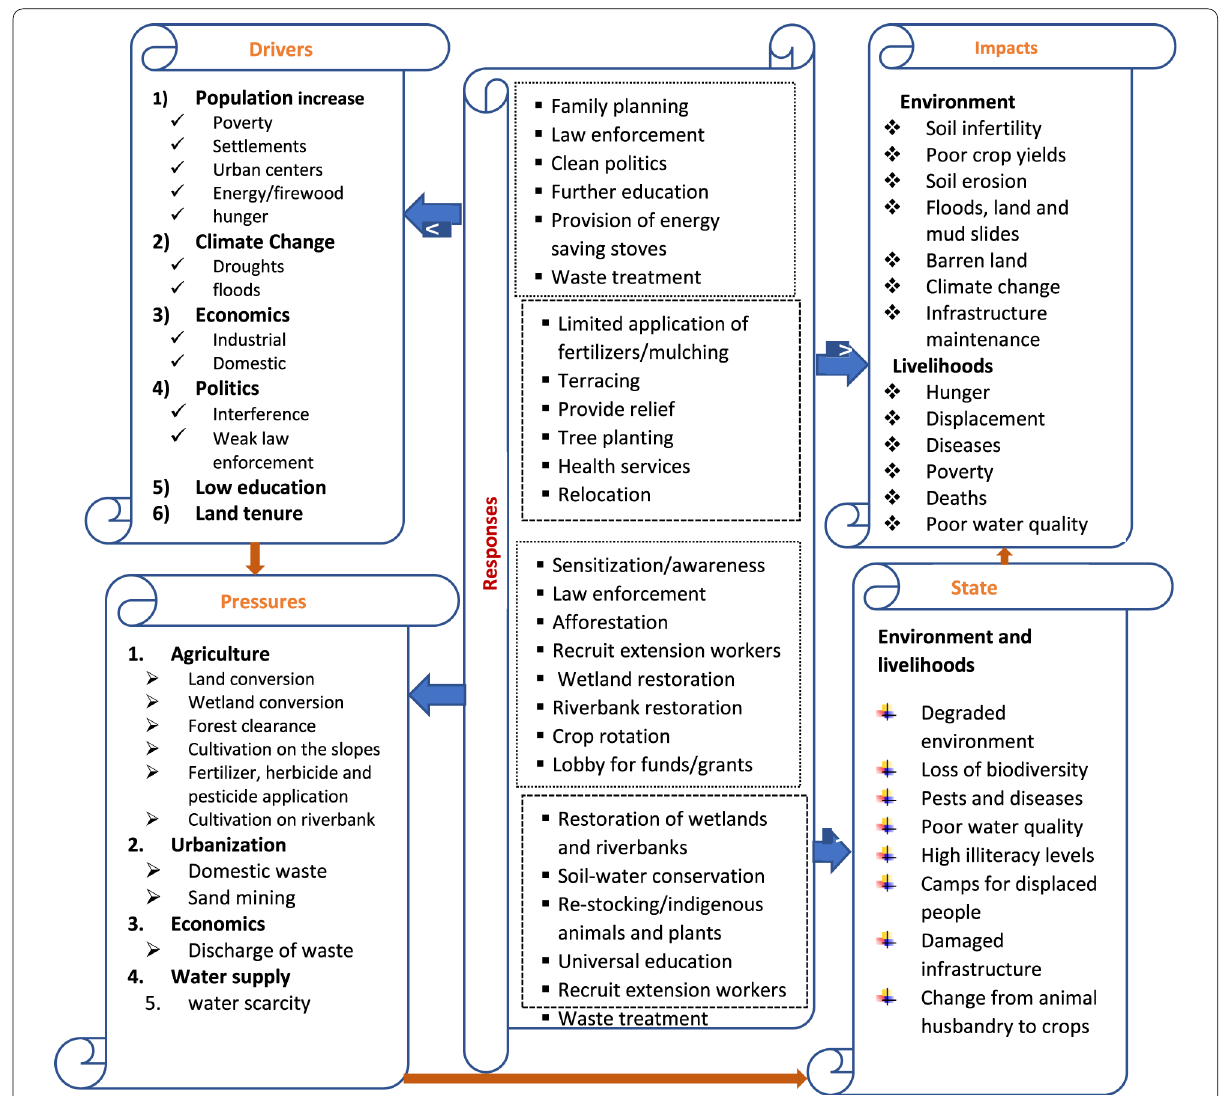
Fig. 4 DPSIR framework model of the findings of LULC change and CC in the study